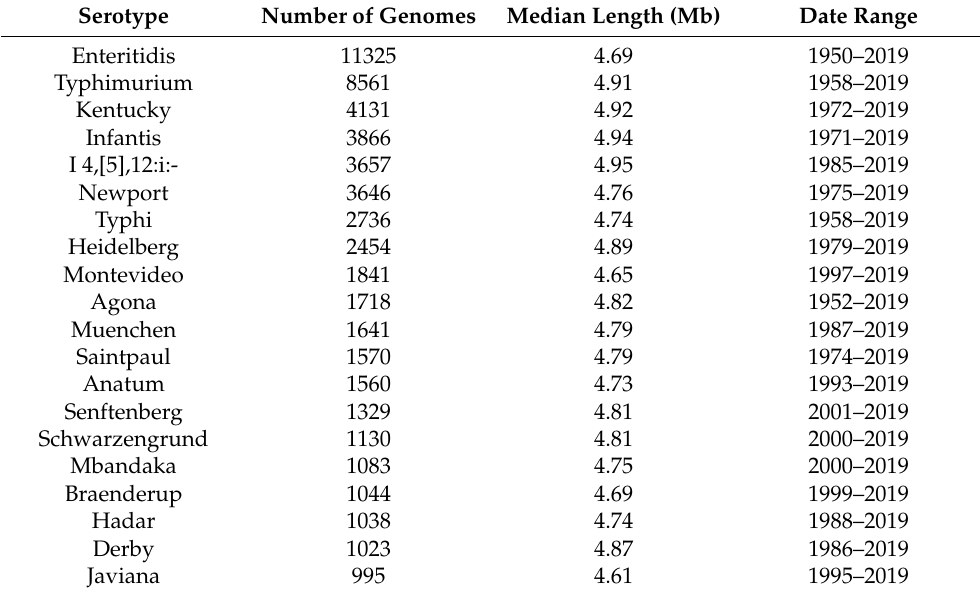
Table 1. List of serovars and number of genome assemblies, median assembly length, and date range of assemblies used to identify co-occurrence of metal and antibiotic